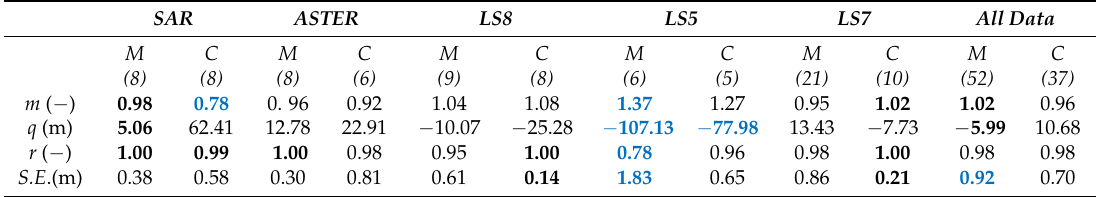
Table 6. Main statistical indicators evaluating the performance of visual matching ( M ) and classification ( C ) techniques on different datasets. Best and worst values in black bold and blue bold, respectively. SAR